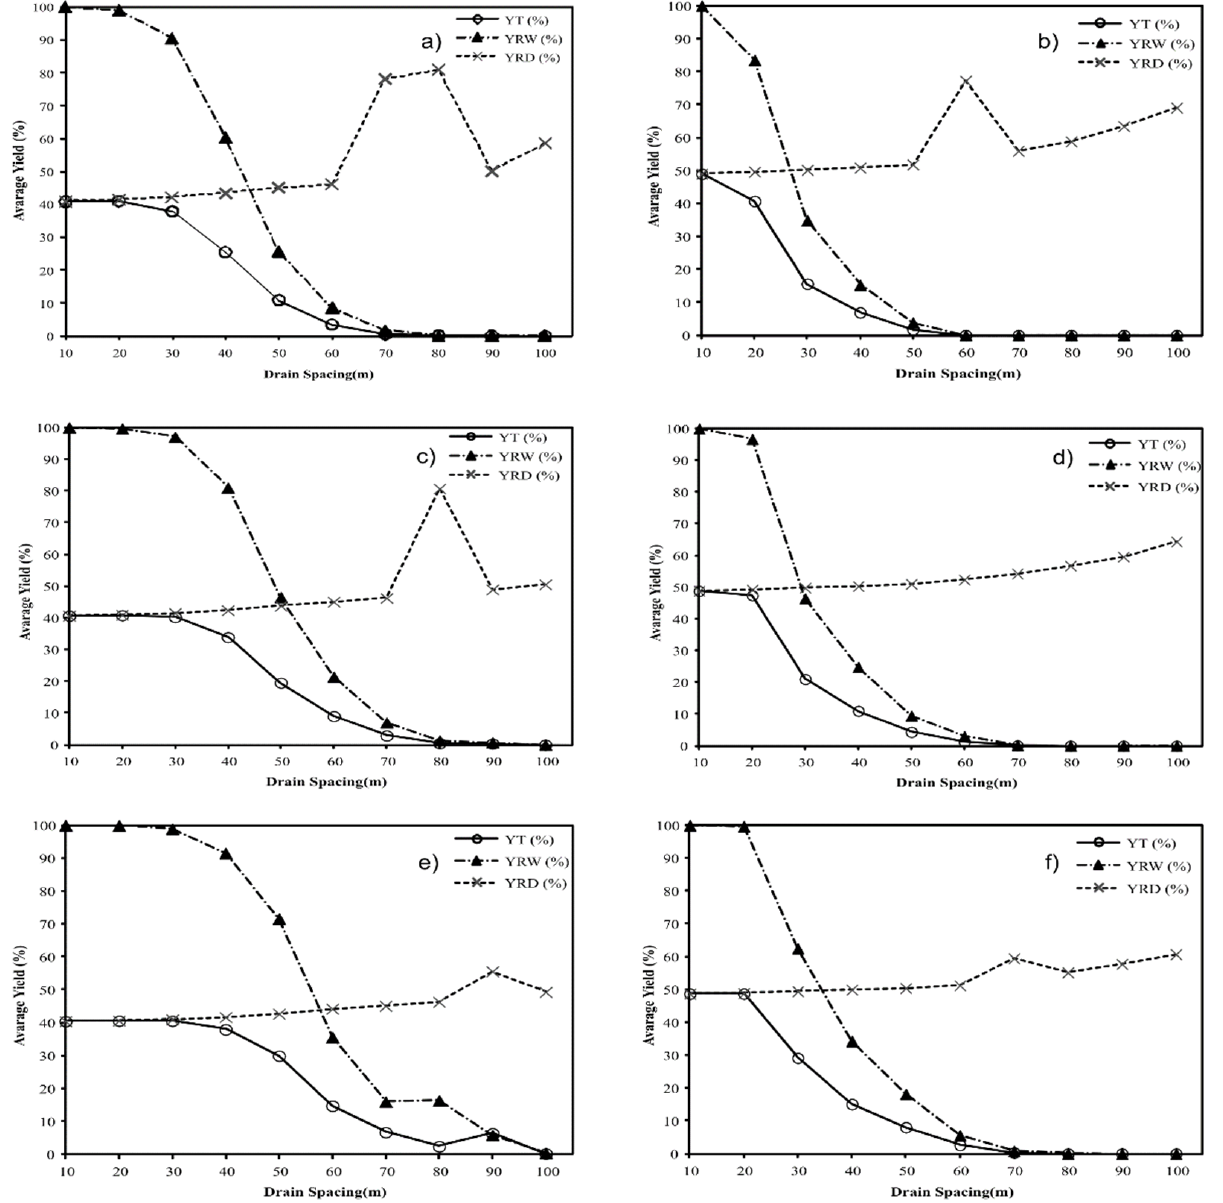
Figure 7. Yield due to excess of water (YRW), deficit (YRD) and total (YT) for sugarcane in the period of 1972–2012, for soil 2 for drain spaces varying from 10 to 100 m and drain depths of 1.2 ( a , b ), 1.4 ( c , d ) and 1.6 ( e , f ) m in the Barinas ( a , c , e ) and Turen ( b , d , f ) weather stations.